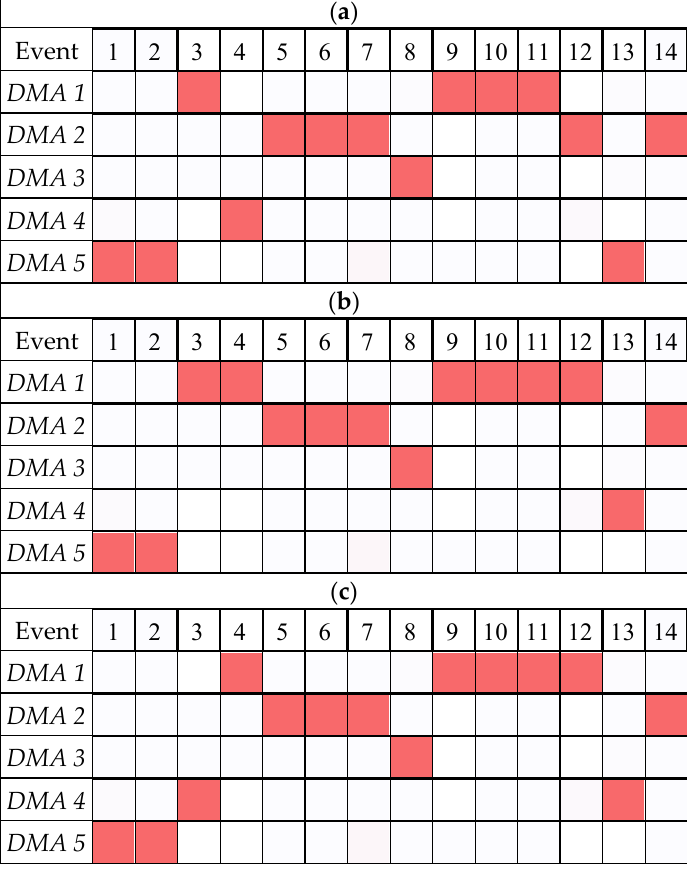
Figure 8. Localization votes by the SSDS modules, illustrating the voting on C-town ’ s events. ( a ) Localization Votes of the WSA Module. ( b ) Localization Votes of the WTA Module. ( c ) Localization Votes of the BSA Module.